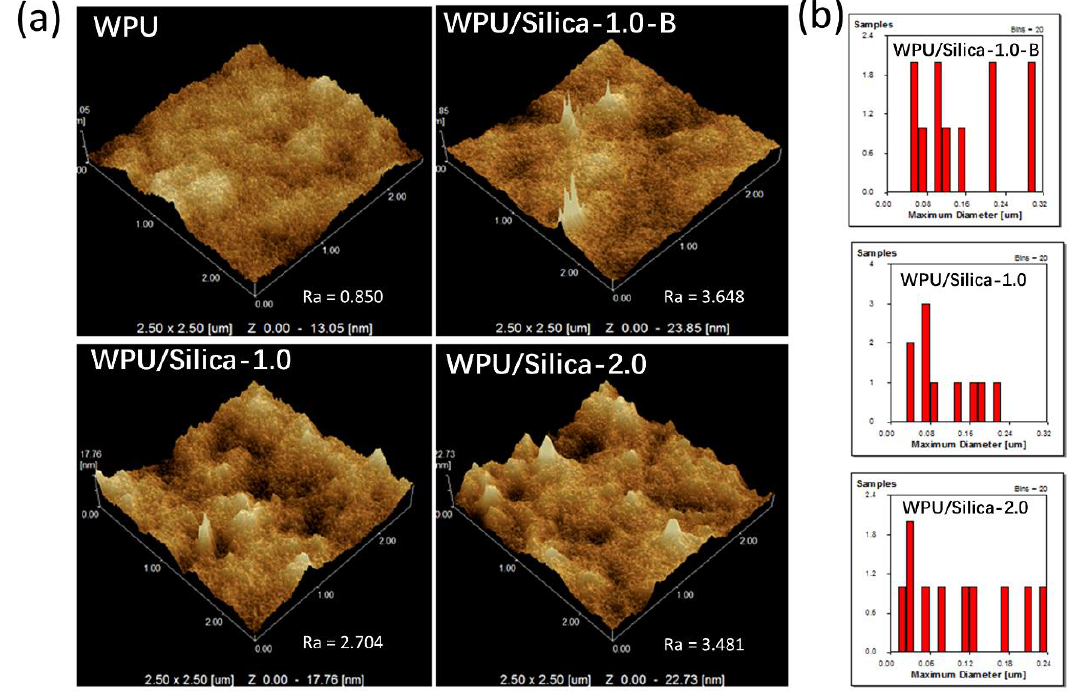
Figure 5. ( a ) 3D topography of WPU and WPU/Silica coatings; ( b ) particle distribution of WPU/silica.